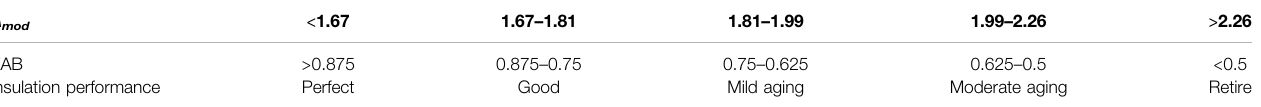
TABLE 7 | Reference for insulation condition evaluation according to A mod .